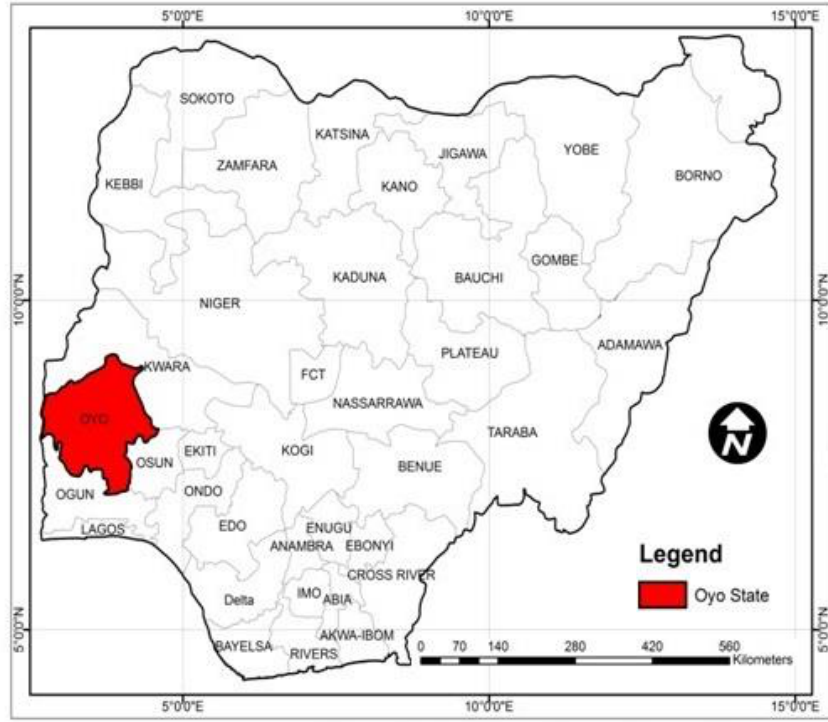
Fig. 1. Maps of Nigeria indicating Oyo State in the shaded portion (Source: Cooperative Information Network [COPINE],